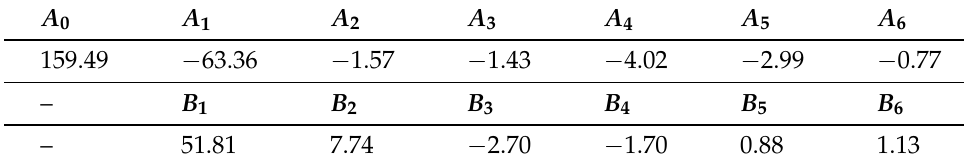
Table 5. Fourier series coefficients for f W ( t )